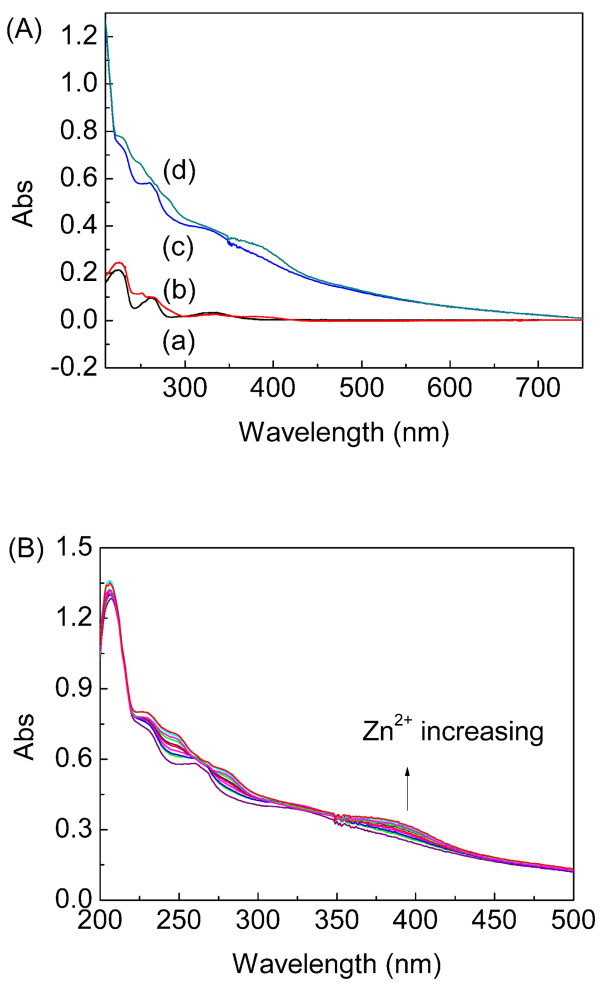
UV-Vis spectra. (A) Absorption spectra of (a) DTH-APTES (1.0 × 10-5 M), (b) DTH-APTES + Zn2+ (1.0 × 10-4 M), (c) DTH-Fe3O4@SiO2 (0.3 g/L), and (d) DTH-Fe3O4@SiO2 (0.3 g/L) + Zn2+ (1.0 × 10-4 M) in ethanol. (B) UV-Vis spectra of DTH-Fe3O4@SiO2 (0.3 g/L) in ethanol in the presence of different amounts of Zn2+ (0 to 240 μM).